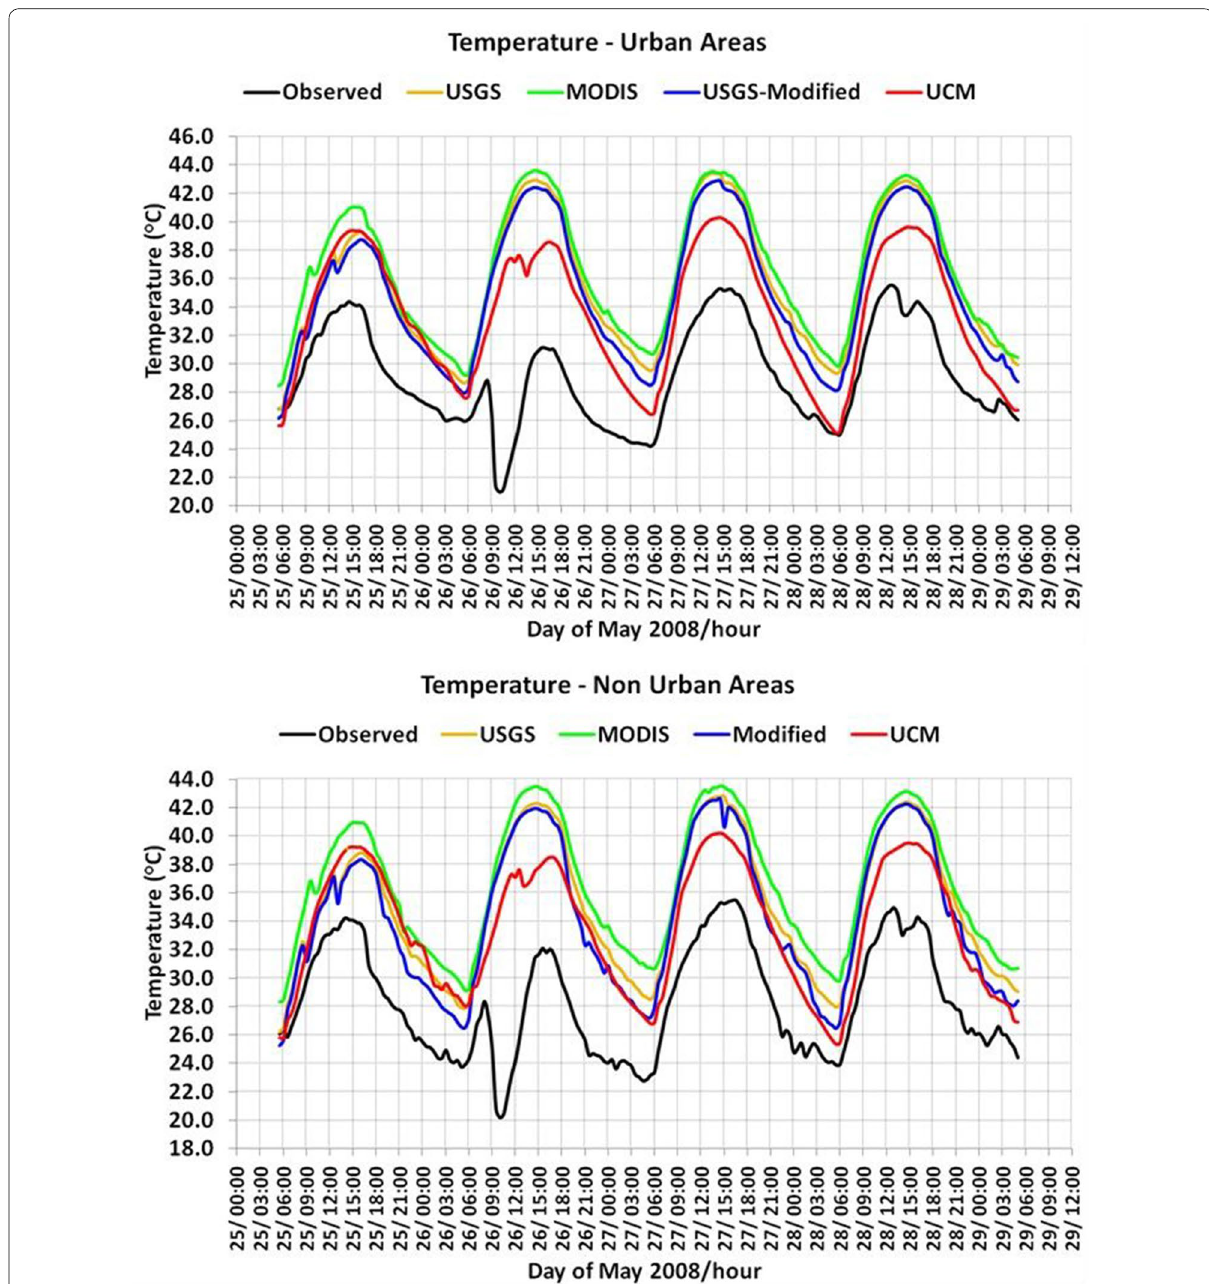
Fig. 3 Time series of near surface temperature 25–28 May 2008 for WRF simulations with different input